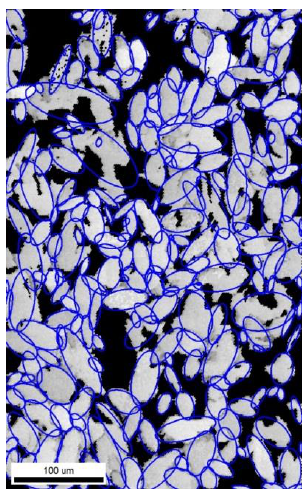
Figure 2. image quality (IQ) map of S25C steel with ellipses fitted to ferrite grains.